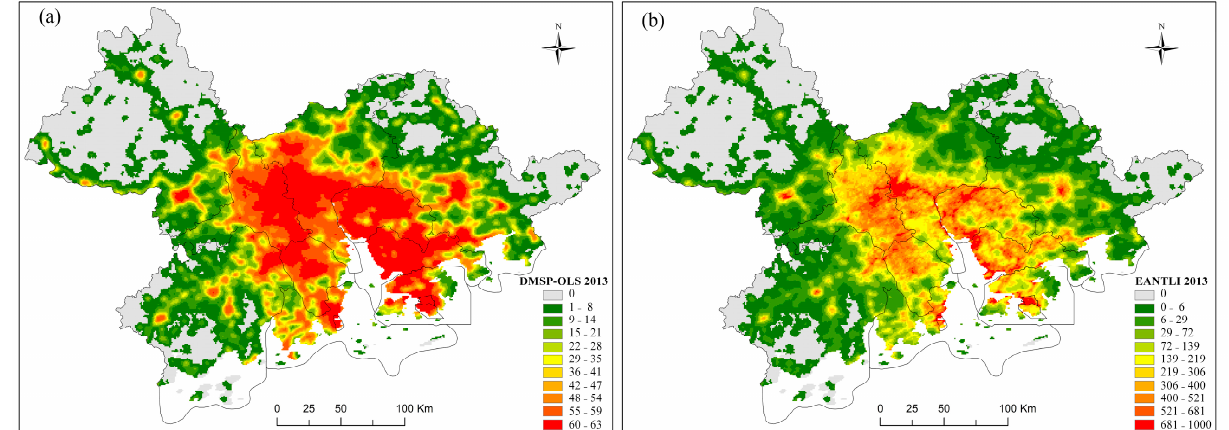
Figure 3. Comparison between DMSP and EANTLI: ( a ) DMSP data; ( b ) EANTLI data.